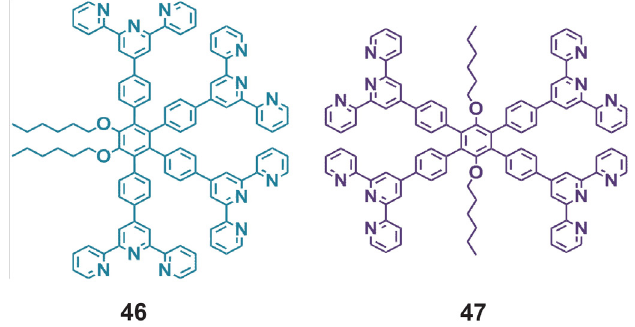
FIGURE 20 – Two new tetra kis terpyridine building blocks that facilitated the synthesis of constitutional isomers.